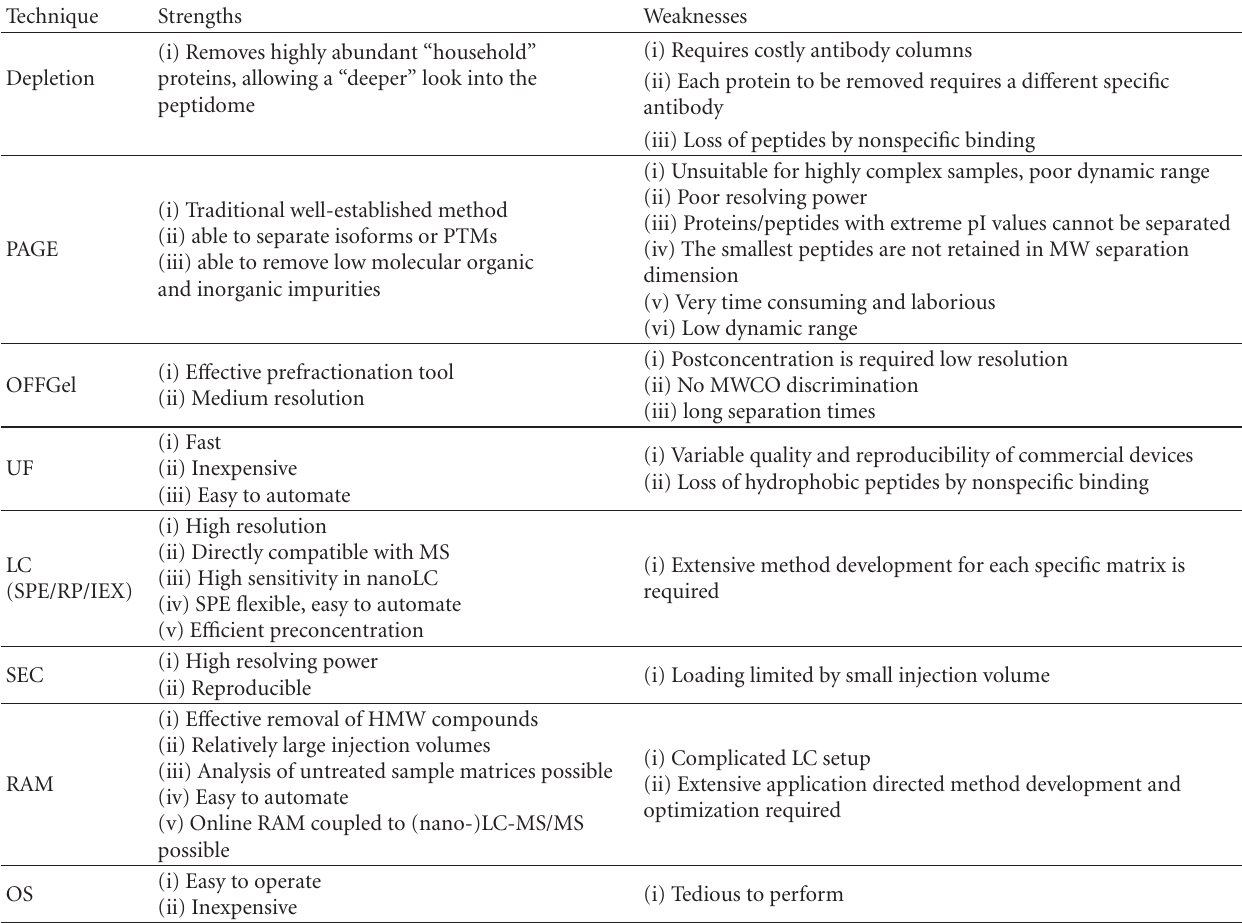
Table 1: Summary of the strengths and weaknesses of analytical tools used in peptidome research as discussed in this review. Abbreviations: IEX: ion exchange; LC: liquid chromatography; MWCO: molecular weight cut-o ff ; OS: organic solvent extraction; PAGE: polyacrylamide gel electrophoresis; RAM: restricted access material; RP: reversed phase; SPE: solid phase extraction; UF: ultrafiltration; SEC: size exclusion